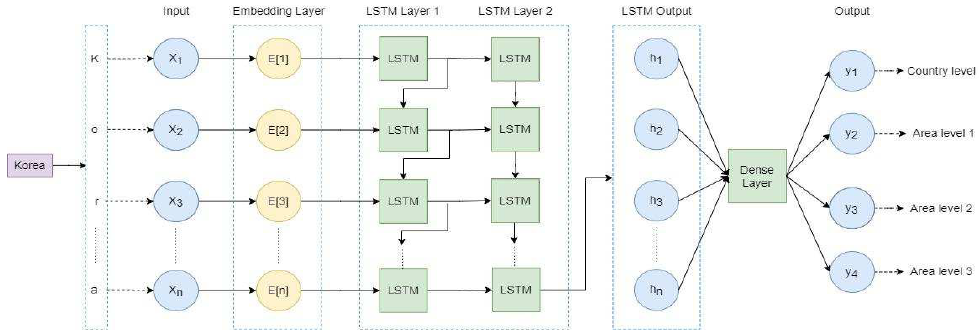
Figure 4. Creation of a deep-learning-based address learning model for address validation.